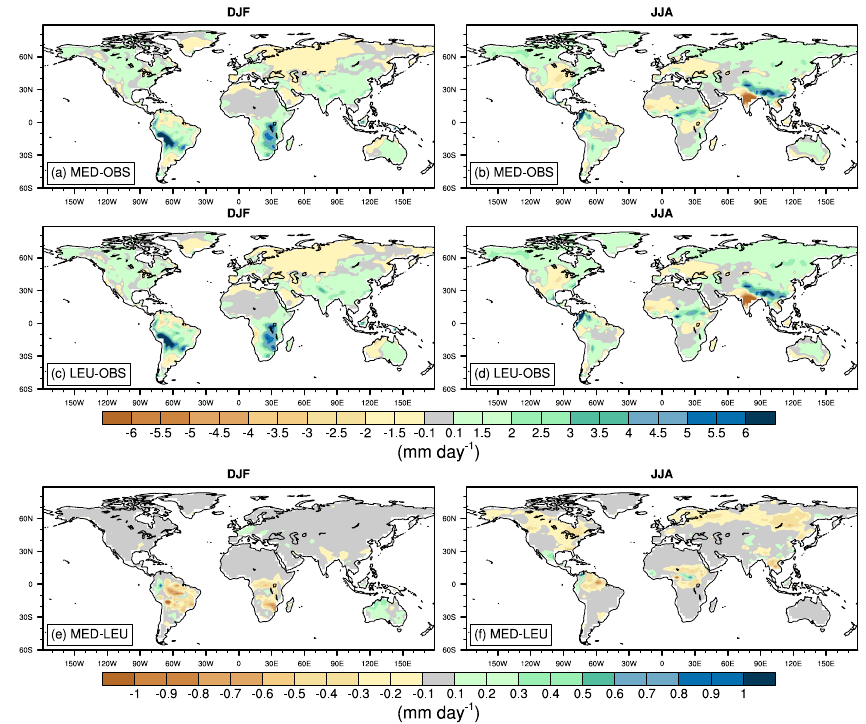
Figure 7. Same as in Fig. 2 except for total precipitation. Observations are from the GPCP data set and seasonal means are computed over the period 1979–2011.